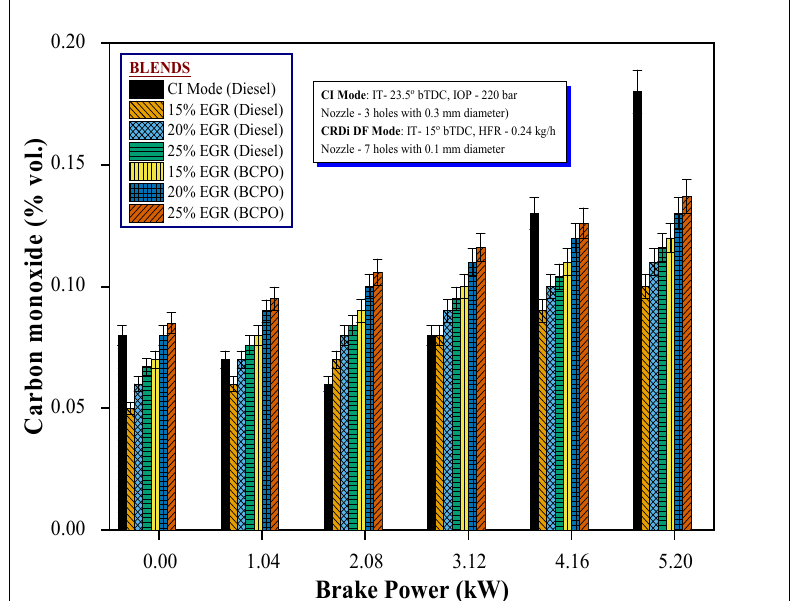
Figure 15. EGR and BP influence on CRDi engine CO emissions.